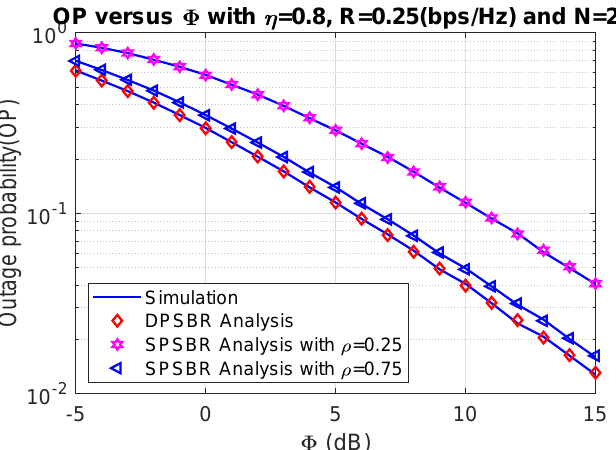
Figure 2. Outage probability versus Φ (dB).